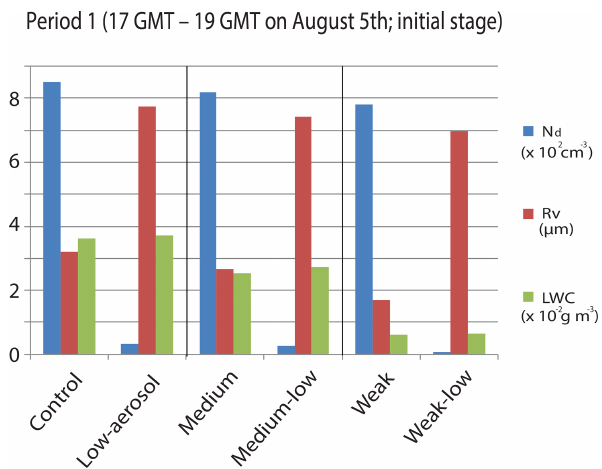
Figure 8. Average N d , R v and LWC at all altitudes in cloudy areas over the period between 17:00 and 19:00GMT on 5